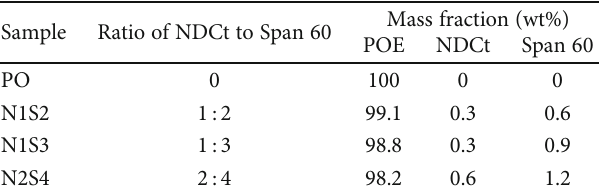
Table 1: The composition of NDCt (N) and Span 60 (S) in the POE